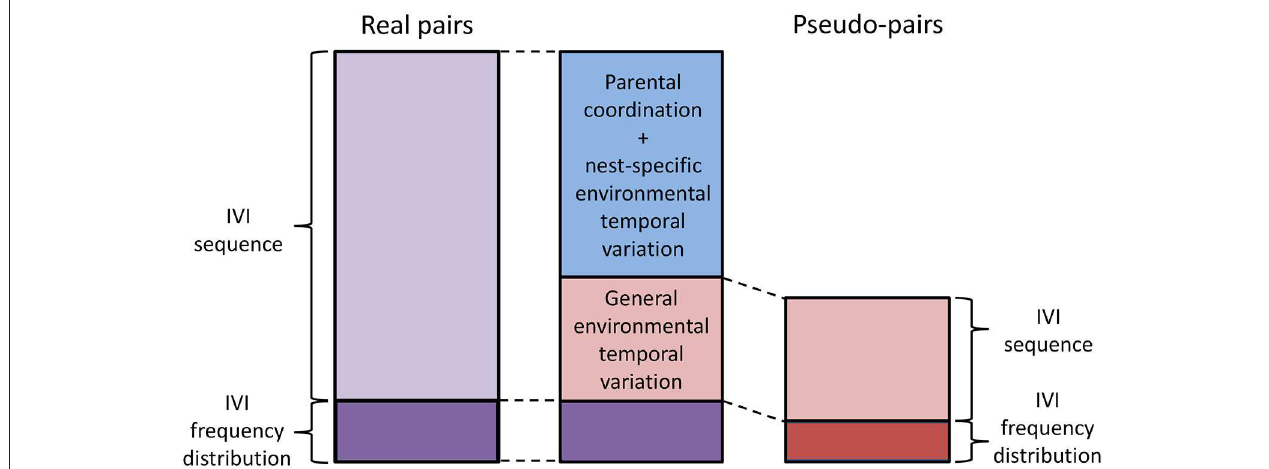
FIGURE 5 | Partitioning the alternation score. To partition the alternation score, the alternation scores of real pairs (entire left-hand bar; purple) and pseudo-pairs (entire right-hand bar; red) are first calculated. Then the alternation scores of randomized real pairs and randomized pseudo-pairs are calculated. These estimate the component due to the IVI frequency distribution (lower section of left- and right-hand bars; darker shade) in real pairs and pseudo-pairs, respectively. The component due to the IVI sequence is then calculated by subtraction for real pairs and pseudo-pairs (upper section of left- and right-hand bars; lighter shade). Finally, the component due to parental coordination (including turn-taking) and/or nest-specific environmental variation is calculated by subtracting the component due to IVI sequence in pseudo-pairs (i.e., the component due to general environmental variation) from the component due to IVI sequence in pairs (blue, because it is calculated by subtraction using components in both pairs and pseudo-pairs). The middle bar shows the final partitioning of the alternation score in real pairs.